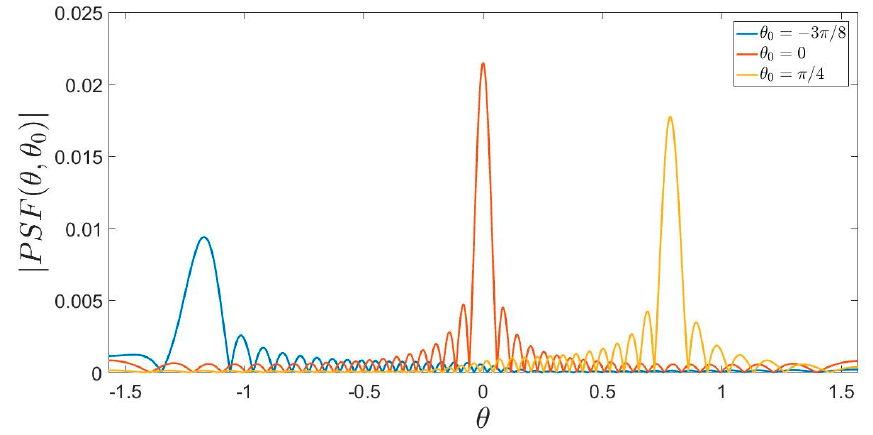
Figure 3. The PSF in the observation domain of the operator ˆ L θ of a linear source with a x = 10 λ , for θ 0 = − 3 π /8, 0, π /4 .